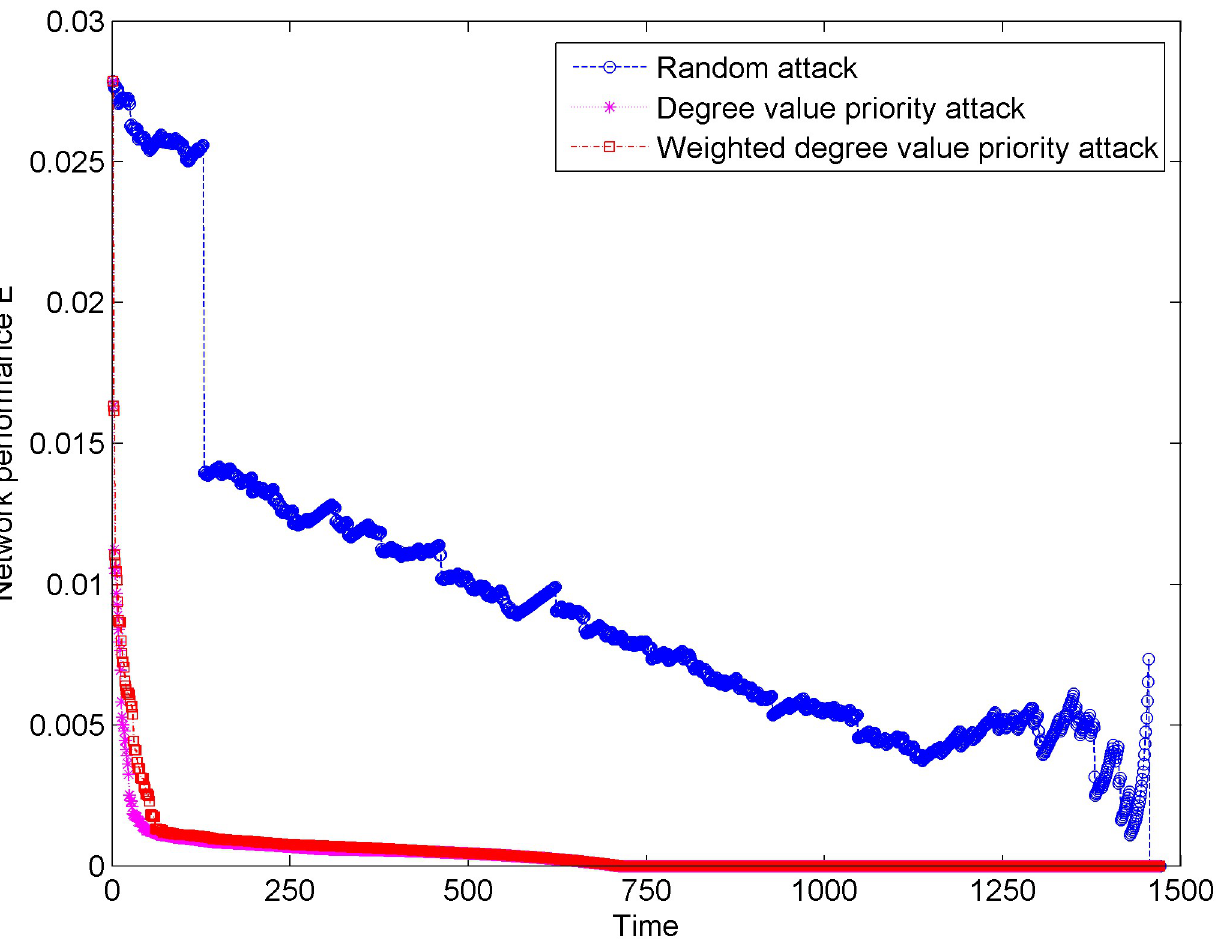
Fig 4. Changes of network performance under three types of